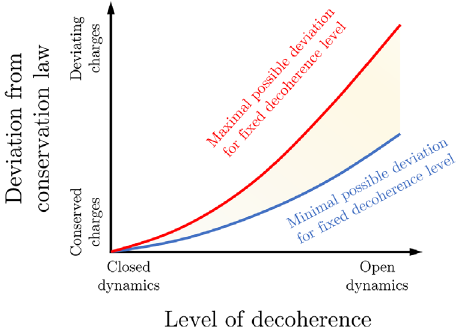
FIG. 3. Robustness of Noether ’ s principle and trade-off rela- tions. A qualitative description of trade-off relations between deviation from conservation laws and level of decoherence under the dynamics of a symmetric channel. While the red upper bound exists for all symmetries described by connected Lie groups, the lower bound is present when quantum systems have multiplicity- free